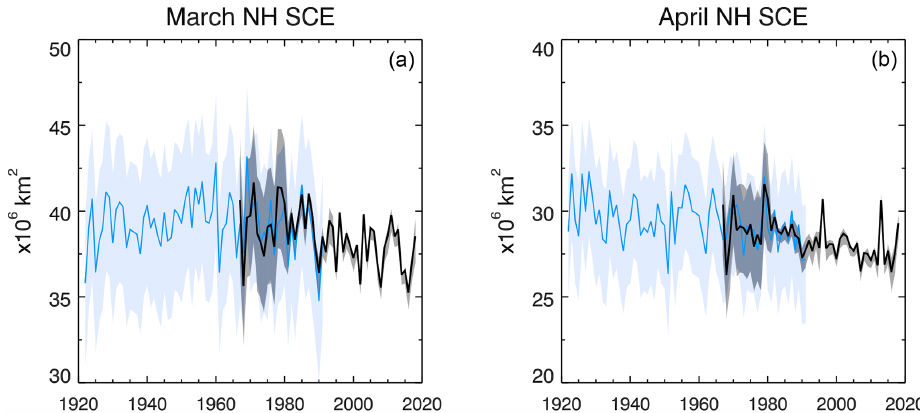
Figure 2. Northern Hemisphere snow extent spanning 1922–2018 for March (a) and April (b) . Snow extent estimates (solid) and uncertainty (shading) are based on station observations (blue) over the 1922–1991 period and the multi-dataset record (black) over the 1967–2018